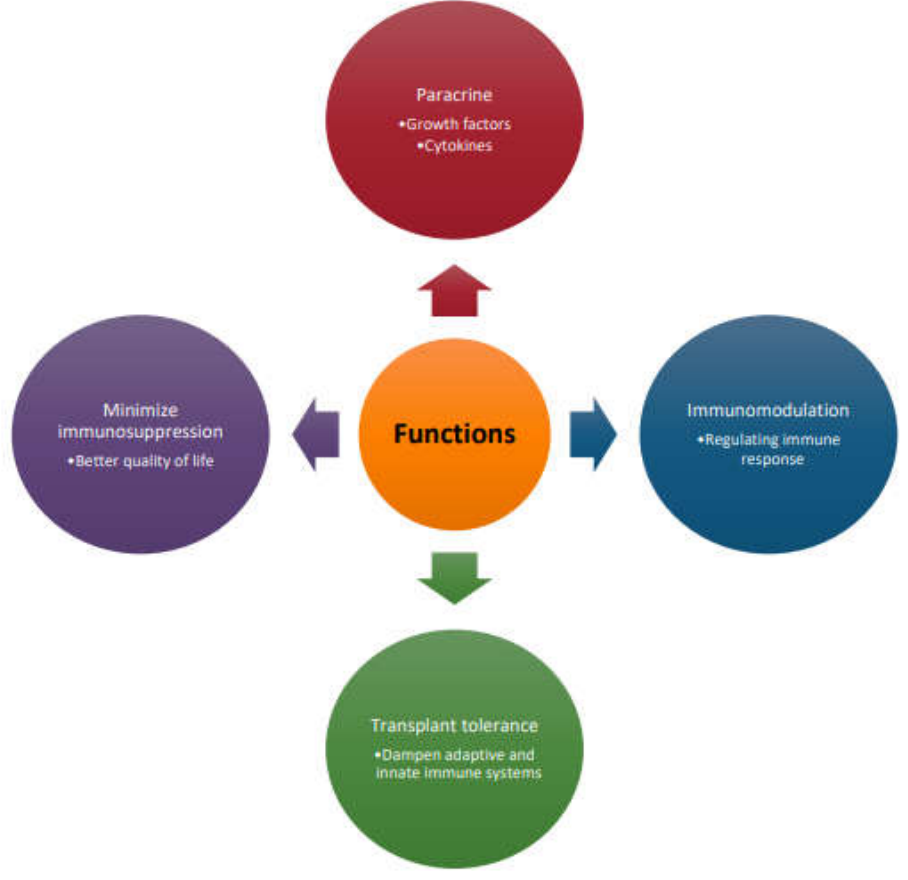
Figure 2. Functional properties of MSC that enable better engraftment of the transplanted organ.